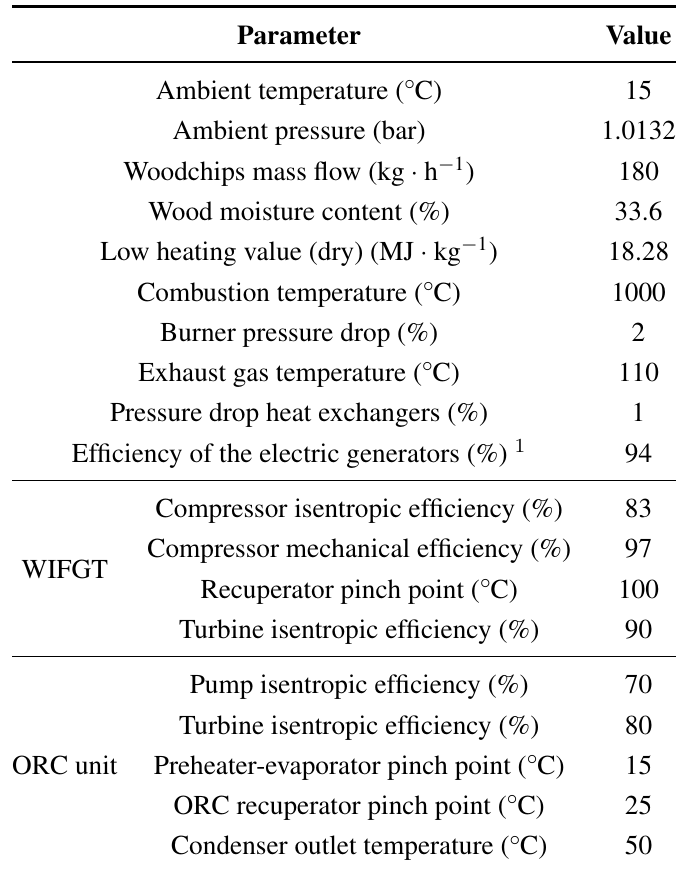
Table 1. Parameters assumed for the integrated WIFGT and the ORC